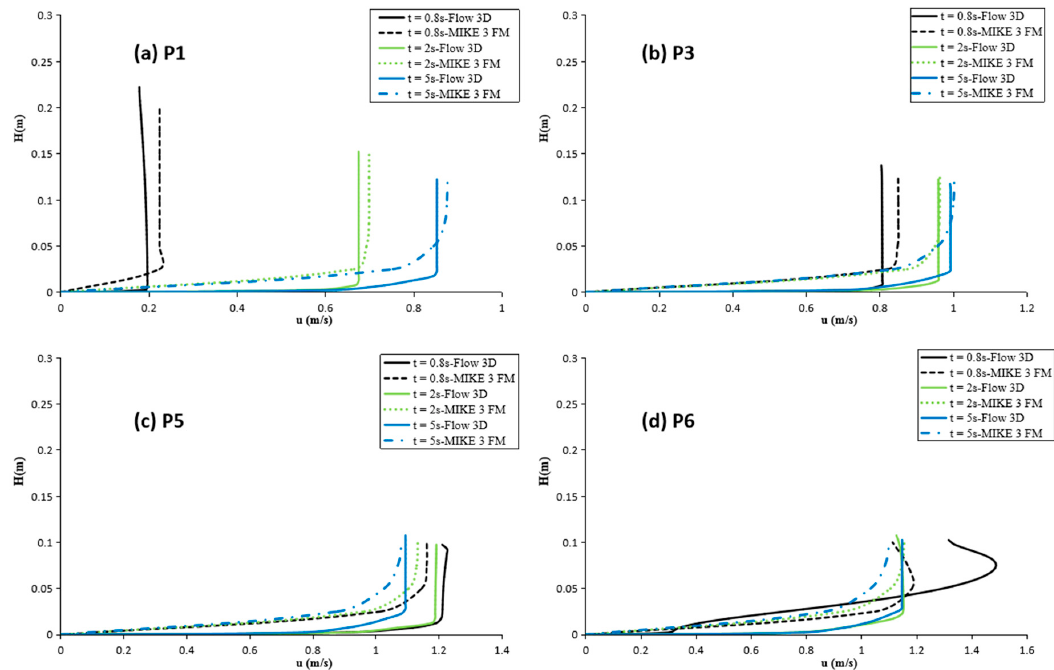
Figure 13. Comparison of simulated velocity profiles at various locations upstream and downstream of the dam at t = 0.8 s, 2 s, and 5 s for water depth ratios α = 0.1 by Ozmen-Cagatay and Kocaman [30]: ( a ) P1( − 1 m); ( b ) P3 (+0.2 m); ( c ) P5 (+1 m); and ( d ) P6 (+2 m).